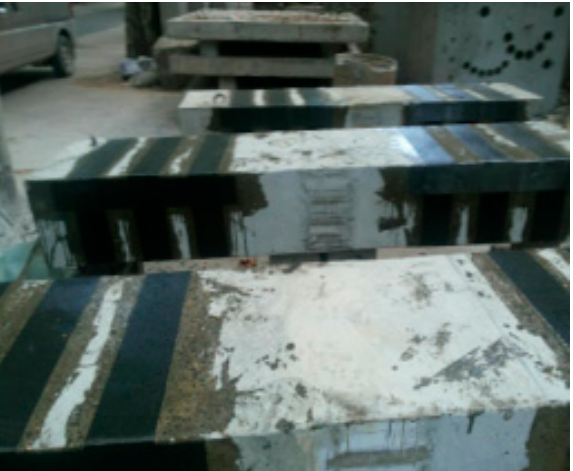
Figure 6. Construction drawing of the test beam reinforced with carbon fiber sheets.